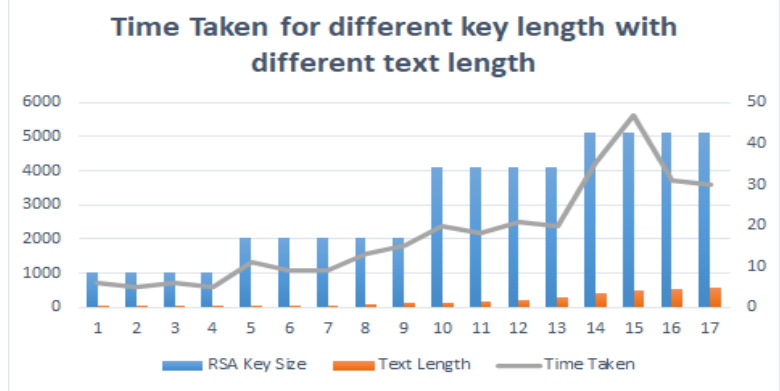
Figure 4. Time taken for different key size with different text